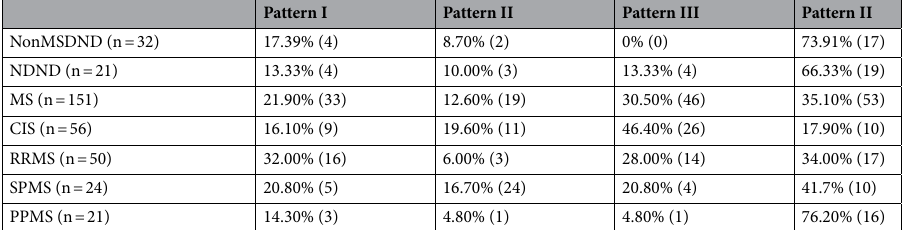
Table 3. Detection of OGIgAB in paired CSF and serum samples from MS and control patients. NonMSDND Non-MS demyelinating neurological diseases, NDND non-demyelinating neurological diseases, MS